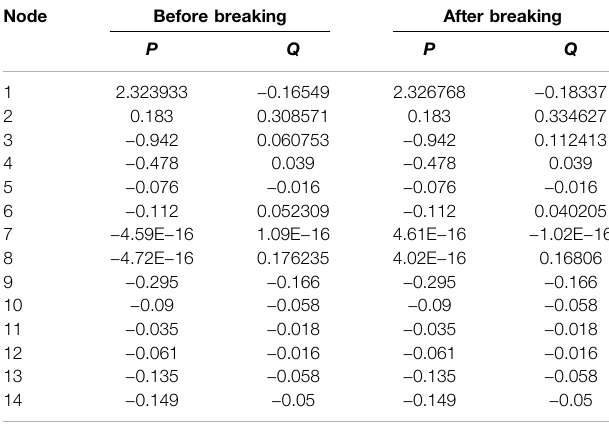
TABLE 3 | Calculation result of power under breaking branches 3 – 4 in the IEEE14 node